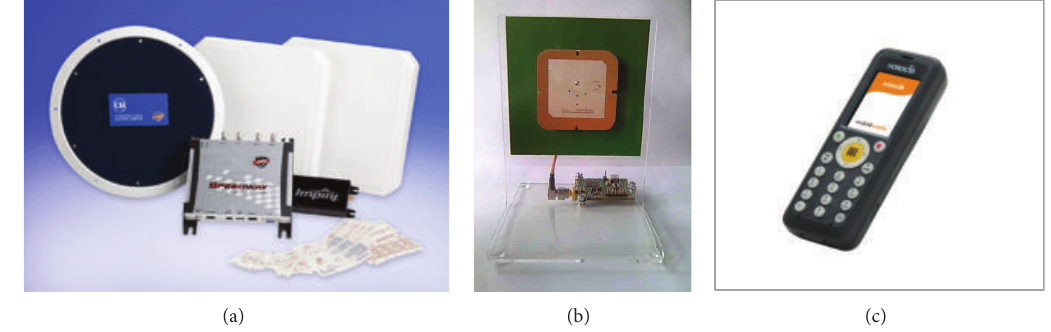
Figure 1: (a) Impinj Speedway [12]; (b) ams AS3991 [13]; (c) Nordic ID Morphic